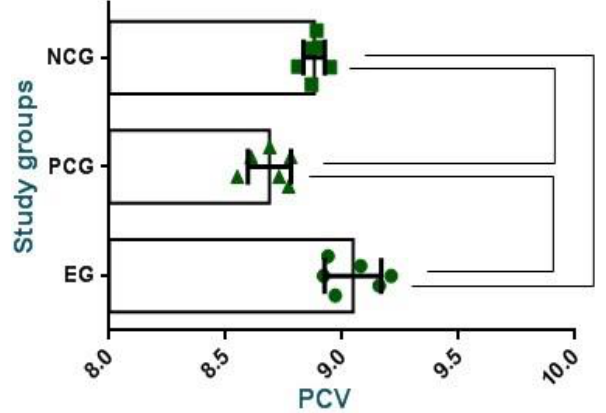
Figure 9. Total results of PCV among the experimental groups and the time